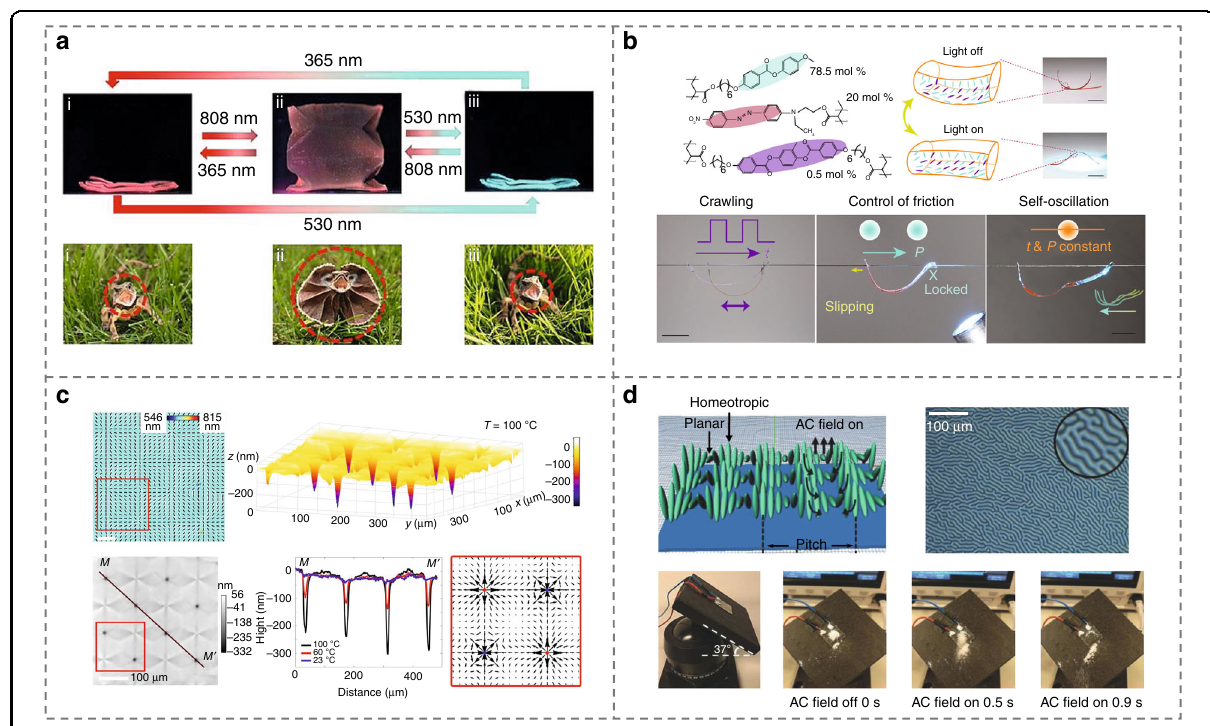
Fig. 13 Polymerized LC fi lms for soft actuators. a Synergistic photochromic luminescence and programmable soft actuators based on LC networks 251 . Reproduced from ref. 251 , with permission of Wiley-VCH. b Light-activated LC actuators climbing on human hairs 261 . Reproduced from ref. 261 , with permission from Wiley-VCH. c LC elastomer coatings with programmed surface topographies 262 . Adapted from ref. 262 , with permission from Springer Nature: Nature Communications. d Electrically driven oscillating fi ngerprints for dust control 257 . Reproduced from ref. 257 , with permission from